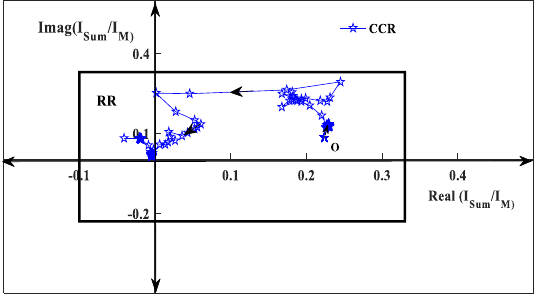
Fig. 7 CCR for single line to a ground fault with R F = 200 Ω Fig. 9 Effect of CT saturation on the proposed